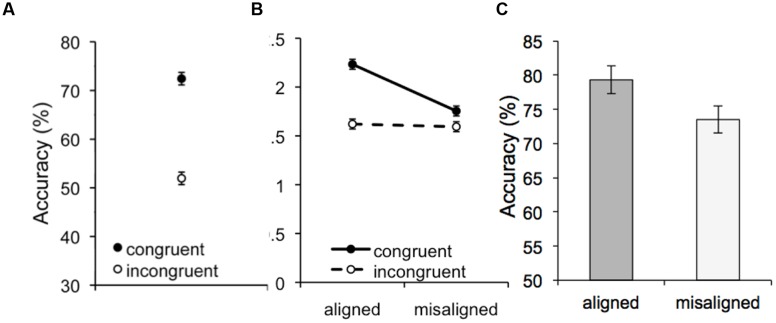
Mean performance for all holistic processing measures.
(A) Accuracy on congruent and incongruent trials in the VHPT-F. (B) Sensitivity (d’) as a function of congruency and alignment in the composite task. (C) Accuracy for same-incongruent aligned and misaligned trials in the composite task. Error bars show 95% confidence intervals for within-subject effects (Loftus and Masson, 1994).